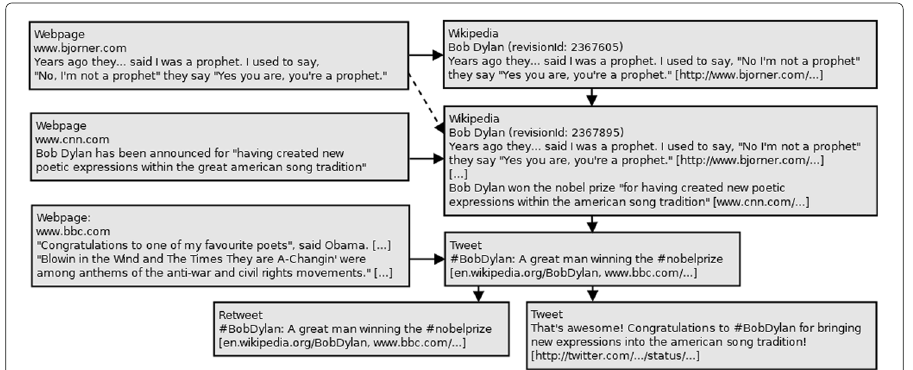
Fig. 1 Example of interdependencies between contributions in different types of online media